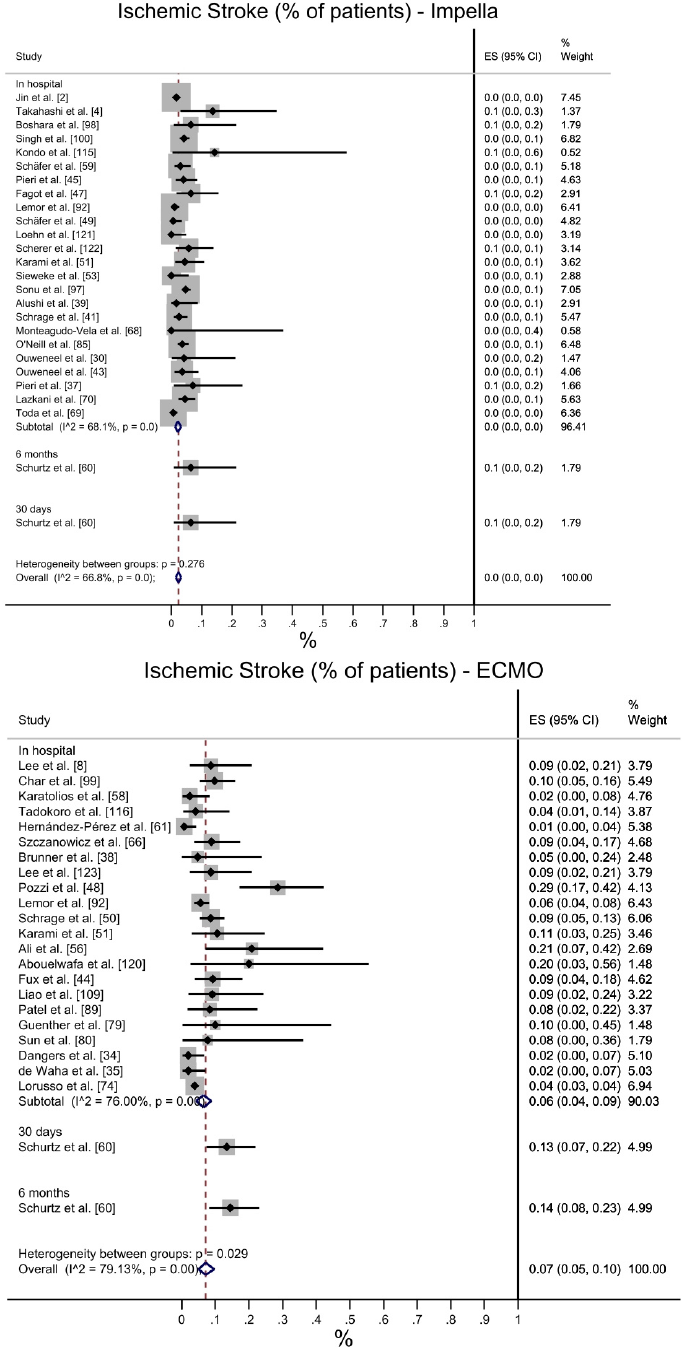
Figure 6. Ischemic stroke: Impella vs. VA-ECMO. [2,4,8,30,34,35,37–39,41,43–45,47–51,56,58–61,66,68–70,74,79,80,85,89,92.97–100,109,116,120–123,] The percentage of patients bridged to long-term LVAD is the same for Impella and VA-ECMO groups (10%), without statistically significant differences (Figure S2). 3.3.7. Bridge to Transplant The percentage of patients bridged to heart transplant is 4% (CI 95%: 0–12%) in Impella, and 6% (CI 95%: 3–9%) in VA-ECMO, although the difference is not statistically significant (Figure S3). 3.3.8. Renal Failure Renal failure events had a similar frequency for the populations treated with Impella (34% ES, CI 95%: 26–43%) and with VA-ECMO (38% ES, CI 95%: 31–42%), although this lacks statistical significance. High level of overall heterogeneity was reported for both devices (Figure S4). 3.3.9. Days on Support